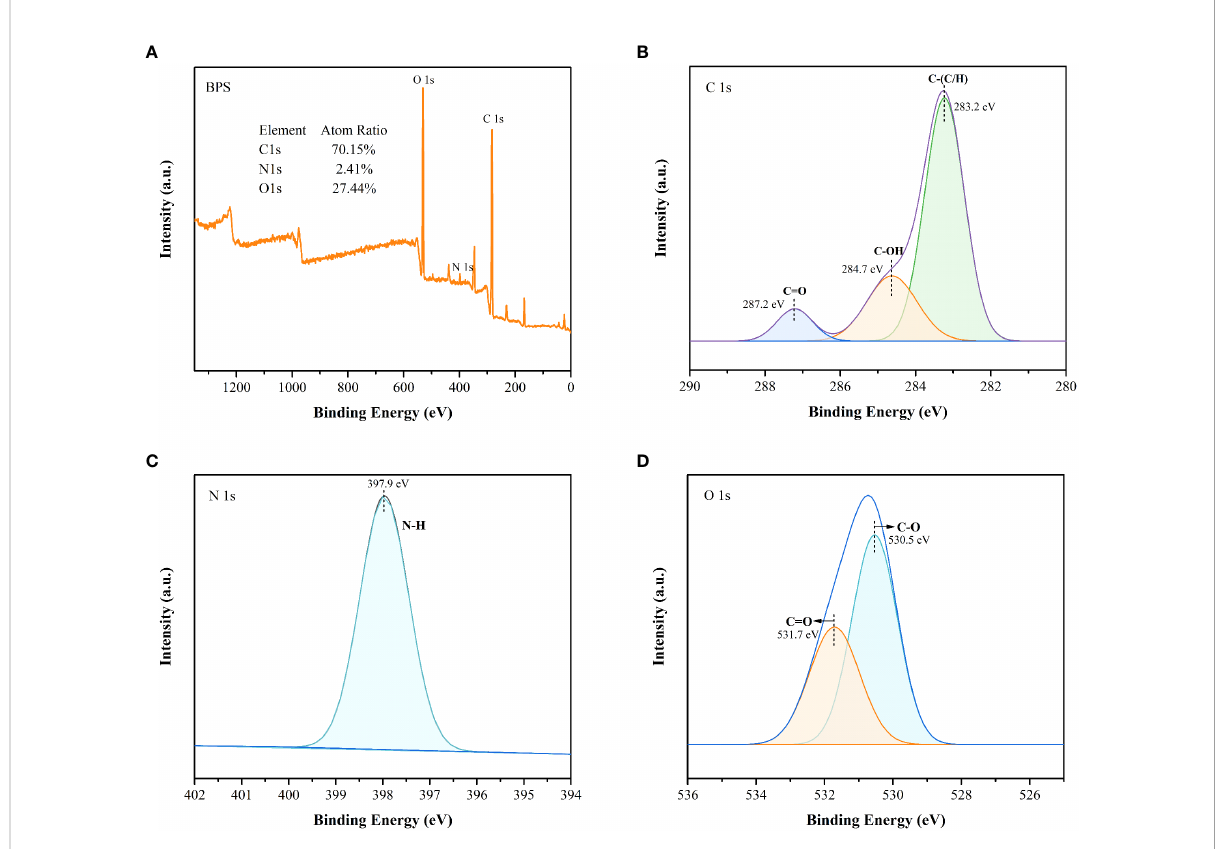
FIGURE 6 The wide spectra (A) and high-resolution XPS peaks of C1s (B) , O1s (C) , and N1s (D)